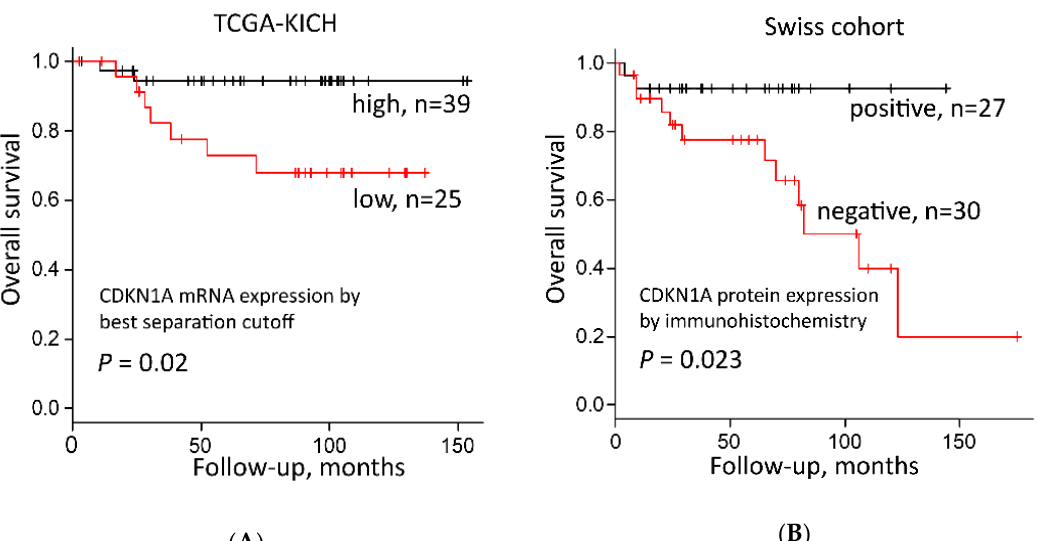
Figure 3. Survival analysis of CDKN1A expression in chRCC. ( A ) CDKN1A mRNA expression and overall survival of 64 chRCC patients in the TCGA-KICH dataset from the Human Protein Atlas [23]—best cut off was according to FPKM values (Fragments per kilo base per million mapped reads); ( B ) CDKN1A protein expression and overall survival of 57 chRCC patients from the Swiss cohort dataset.